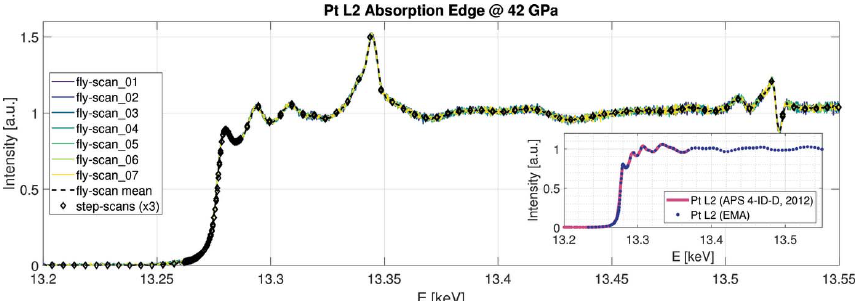
Figure 13 XAS spectra of a Pt foil under 42 GPa in a diamond anvil cell setup at EMA. Measurements over the Pt L 2 -edge were repeated ten times in fly-scan (27 s each) (three runs lost due to a vacuum interlock fault at the beamline) and three times in step-scan (6 min each), demonstrating the high- performance spectroscopy capabilities available at EMAwith the HD-DCM and the APU22 source. The inset shows a simultaneous reference measurement of standard Pt sample, being compared with a previous measurement at the APS 4-ID-D beamline. Further discussion is provided in the